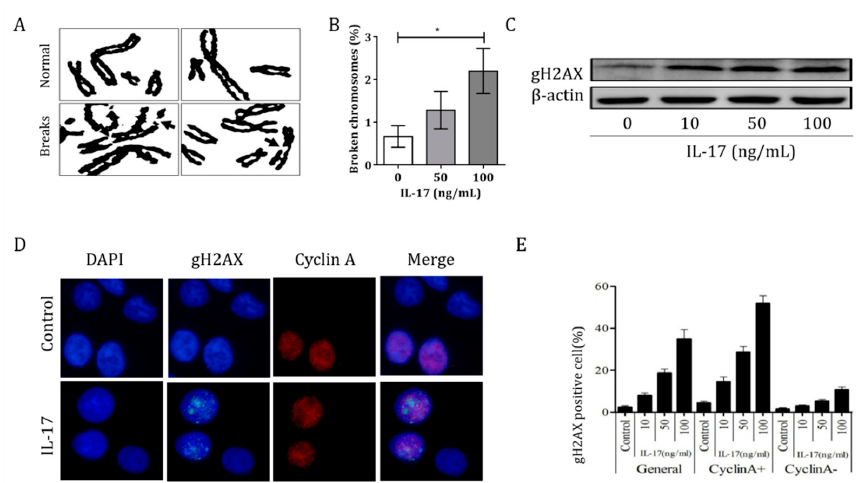
Figure 3. IL-17-induced genomic instability in bronchial epithelial cells. ( A ) Arrows denote broken chromosomes after IL-17 treatment. ( B ) Numbers of broken chromosomes after treatment with increasing IL-17 concentrations. ( C ) Western blot assay for the expression of gH2AX after the treatment of cells with IL-17. ( D ) Representative images of gH2AX and cyclin A staining in control and IL-17 treatment groups (magnification 10 × 100). ( E ) Percentages of gH2AX-positive cells in cyclin A + and cyclin A - cells. (Data are presented as mean ± SEM, * p < 0.05).